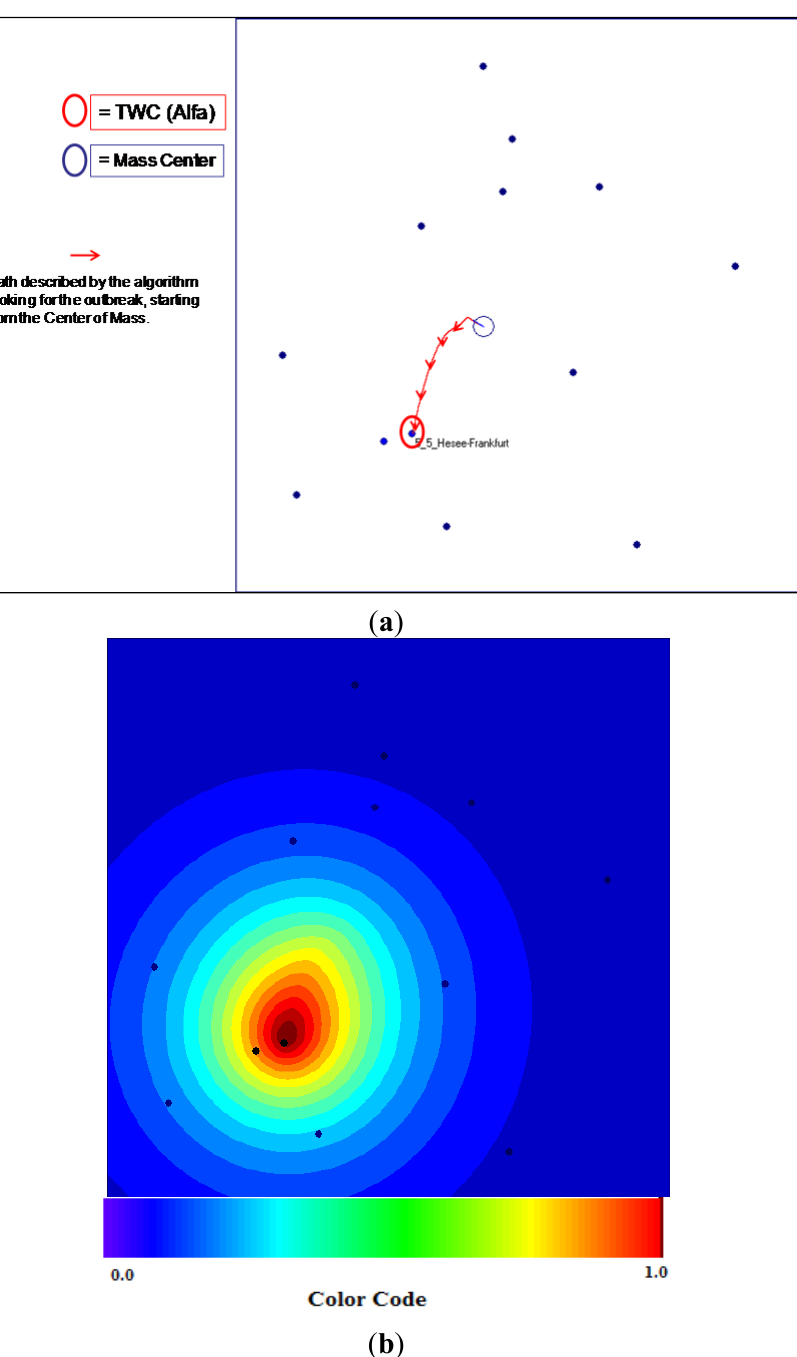
Figure 10. ( a ) TWC ( α * ) points out the outbreak close to Frankfurt; ( b ) The scalar field of α , the TWSF ( α n n